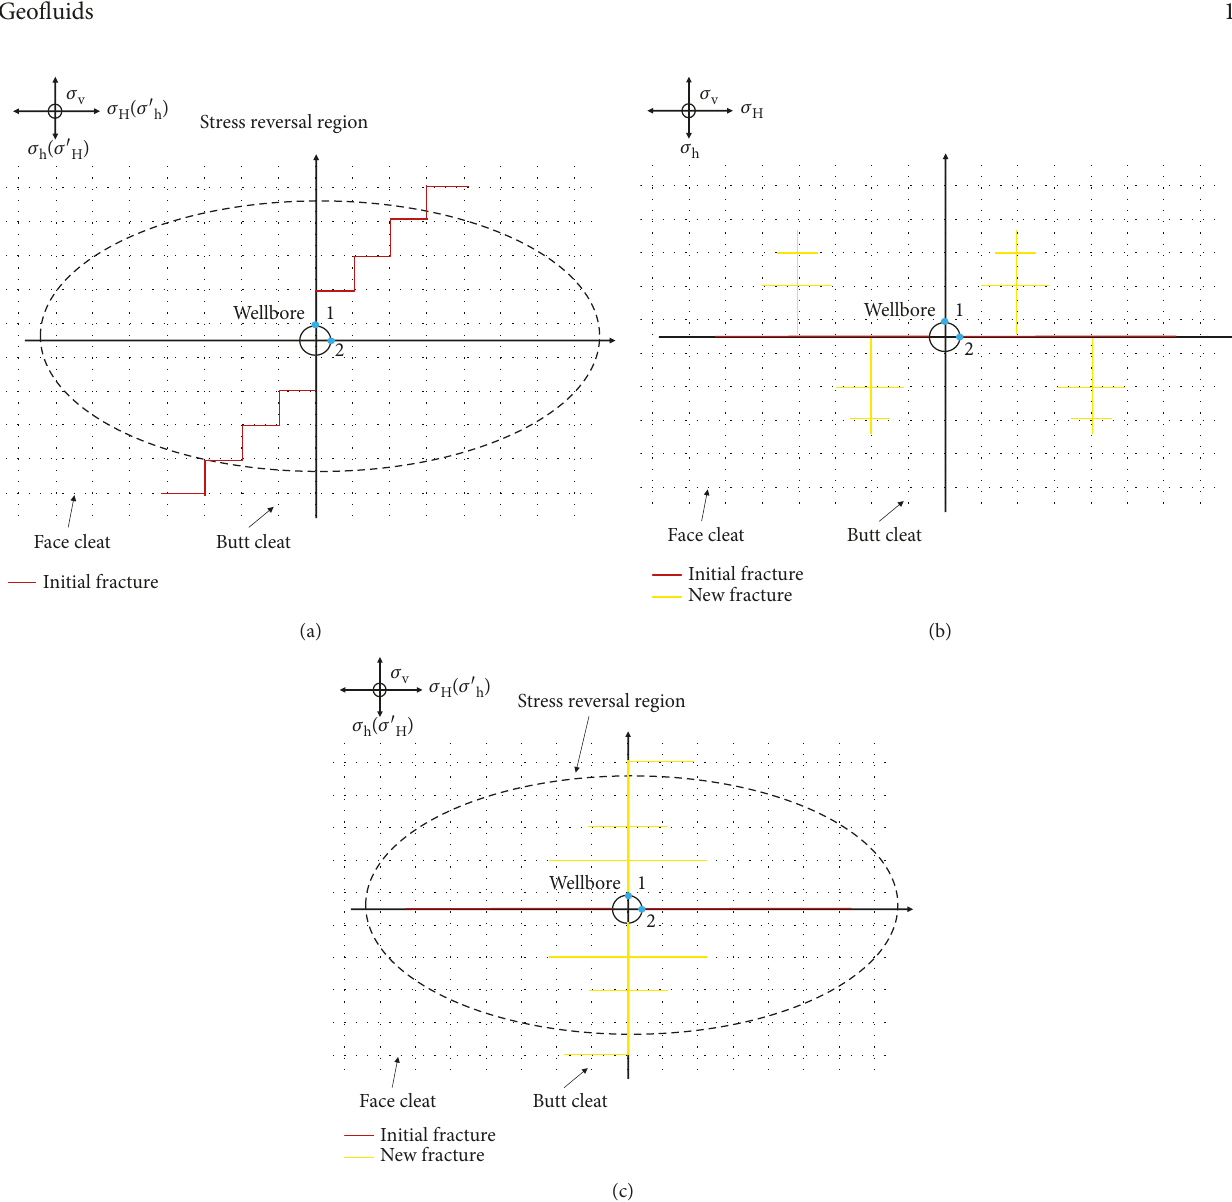
Figure 7: Fracture morphologies under di ff erent conditions in coal seams in refracturing: (a) Δ σ formed; (b) Δ σ h was large (4 – 8 MPa), and the stress fi eld was not changed much and new branches were formed perpendicular to the initial HF; and (c) Δ σ h was large (4 – 8MPa), with stress inversion, and new HFs were created in